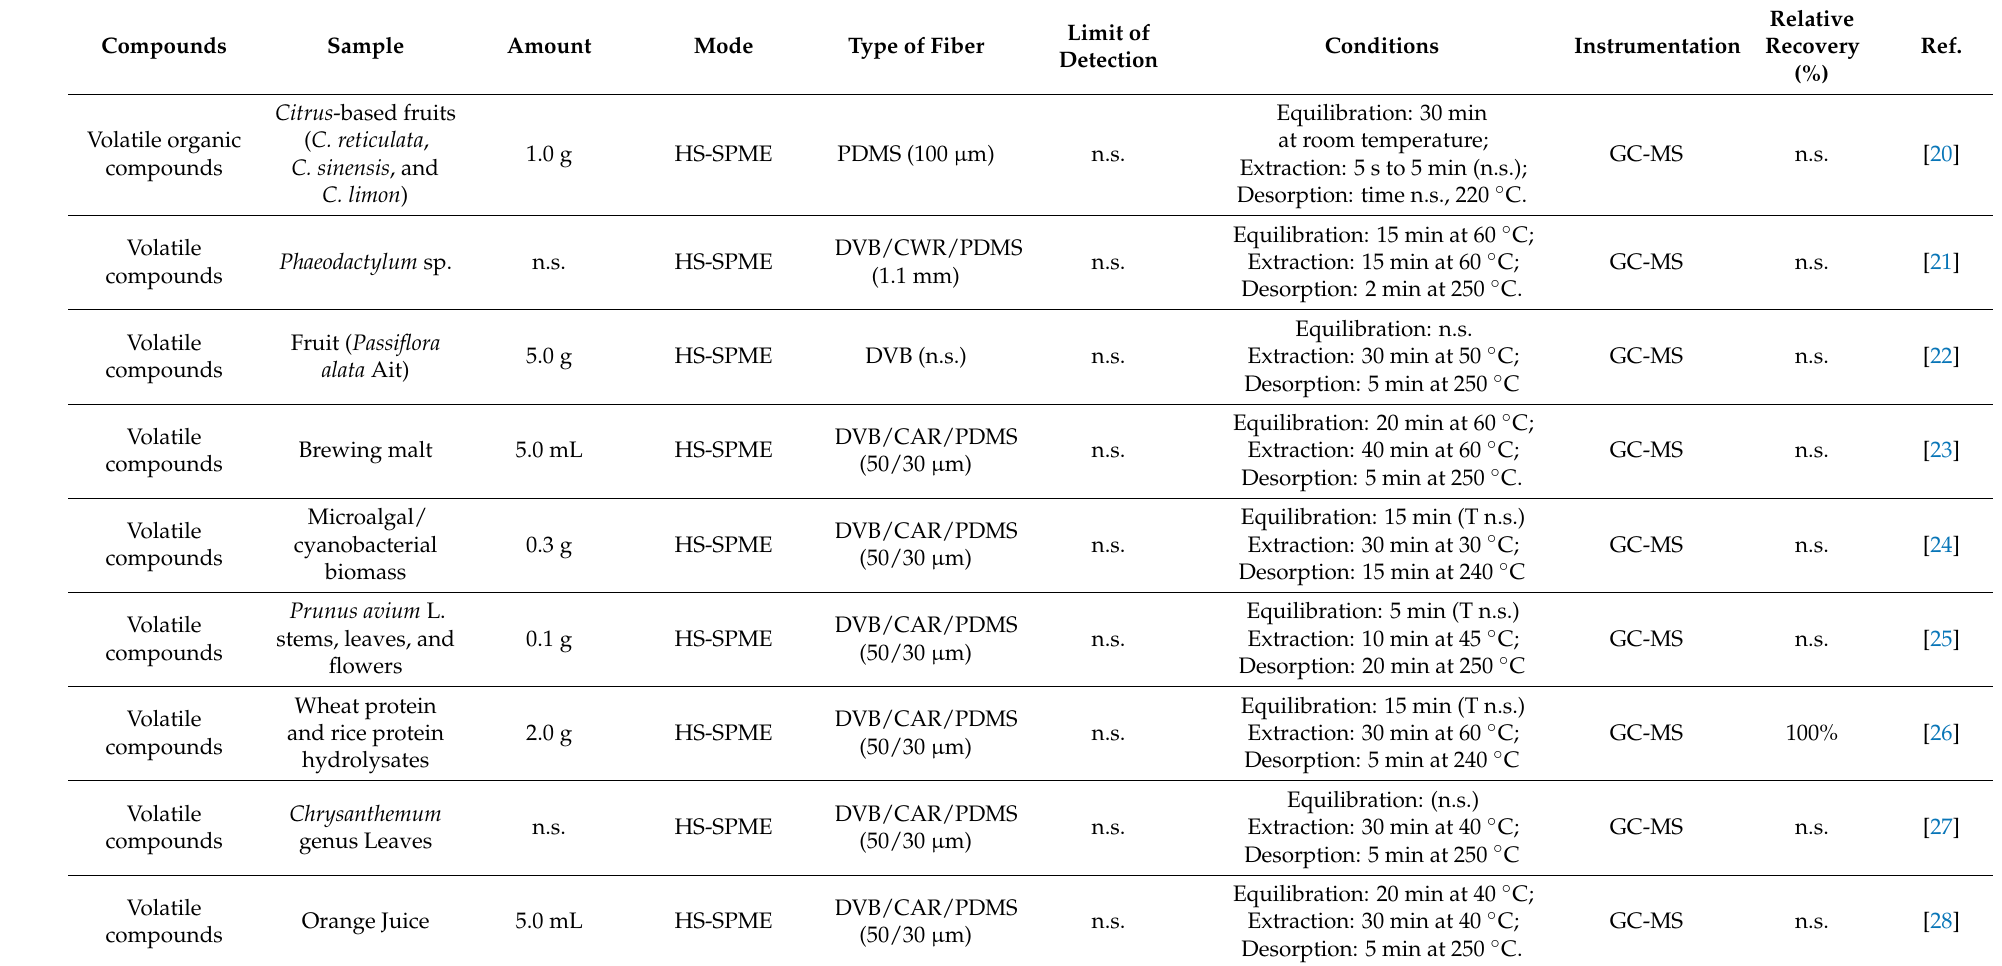
Table 1. Application of SPME techniques for the extraction of several compounds in natural